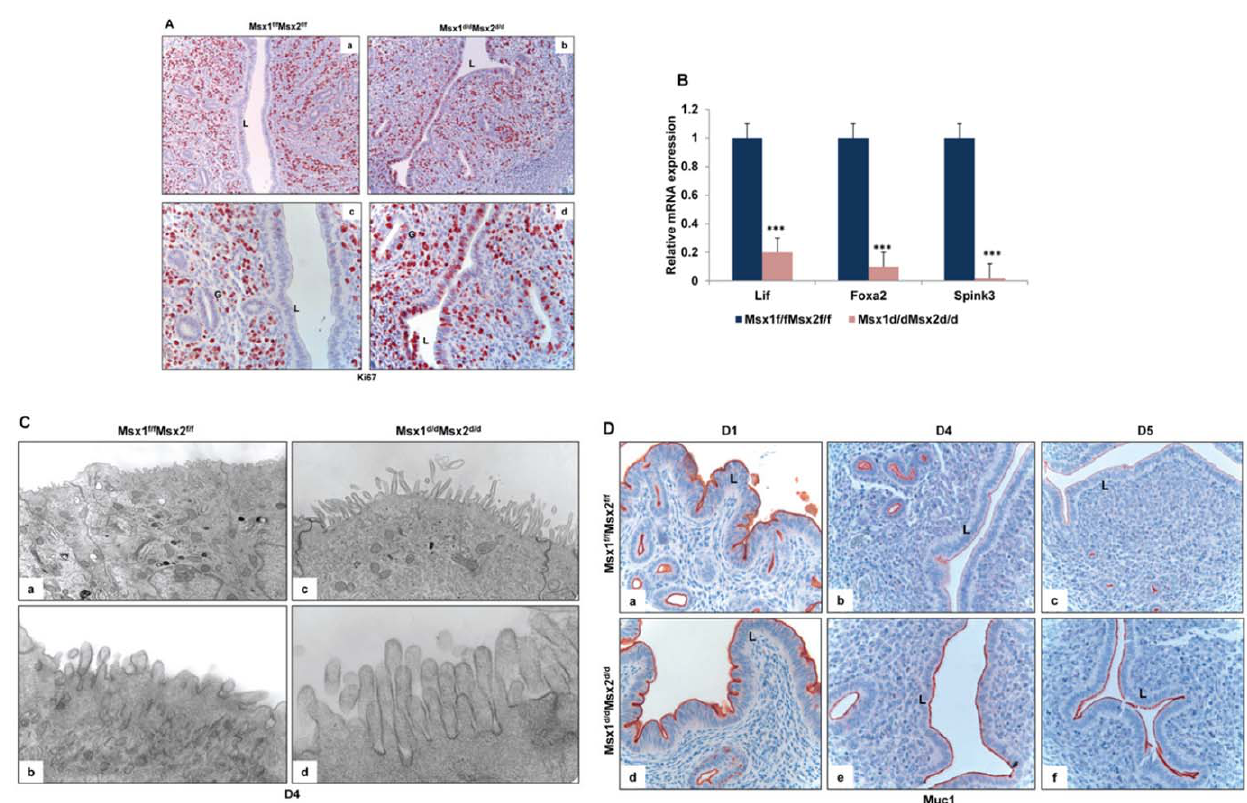
Figure 4. Enhanced proliferation in the uterine epithelium and lack of receptivity in Msx1 d/d Msx2 d/d mice. A. Immunohsitochemical localization of Ki67 in the uterine sections of Msx 1 f/f Msx 2 f/f (left panel, a and c) and Msx 1 d/d Msx 2 d/d (right panel, b and d) mice on day 4 of pregnancy. Panels a and b indicate lower magnification (20 6 ) and c and d indicate higher magnification (40 6 ). L and G indicate luminal epithelium and glandular epithelium respectively. B. Real-time PCR was performed to analyze the expression of glandular factors, Lif , Foxa2 and Spink3 in uteri of Msx 1 f/f Msx 2 f/f and Msx 1 d/d Msx 2 d/d mice on day 4 of pregnancy. The level of Ck18 was used as internal control to normalize gene expression. The data are represented as the mean fold induction 6 SEM, ***p , 0.0001. C. Transmission electron microscopy of uterine sections obtained from Msx1 f/f Msx2 f/f (left panel, a and b) and Msx1 d/d Msx2 d/d (right panel, c and d) mice on day 4 of pregnancy. Panels a and c indicate lower magnification (5Kx) and b and d indicate higher magnification (30Kx). D. Immunohistochemical analysis of Muc-1 expression in the uterine sections of Msx 1 f/f Msx 2 f/f (upper panel) and Msx 1 d/d Msx 2 d/d (lower panel) mice on day 1 (a and d), day 4 (b and e) and day 5 (c and f) of pregnancy. L indicates luminal epithelium.